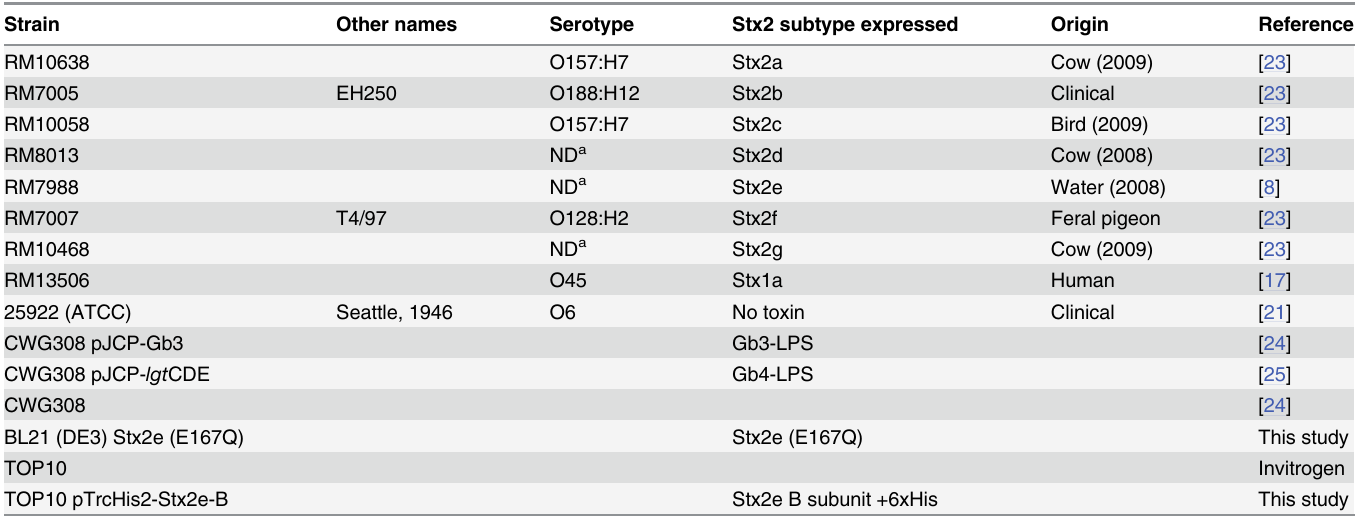
Table 1. E . coli strains used in this